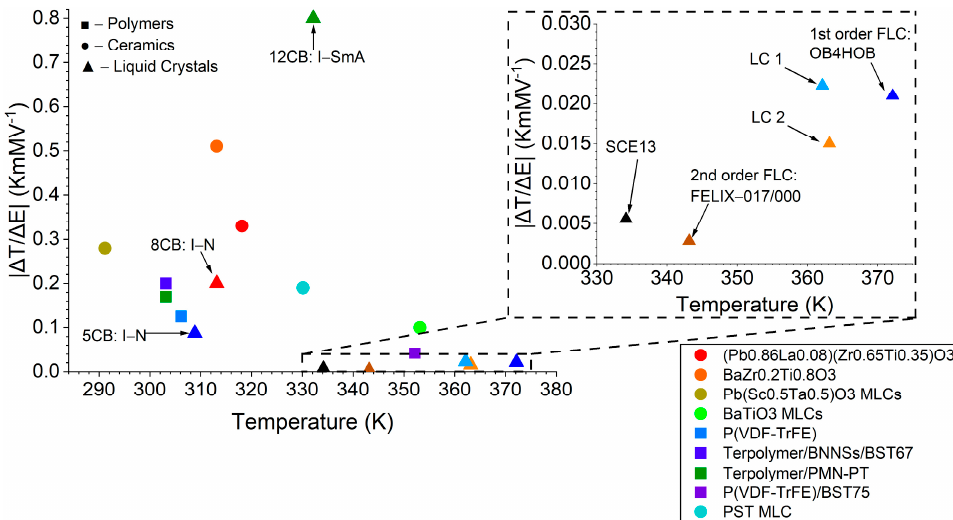
Figure 6. The EC figure of merit, ∆ T / ∆ E , plotted as a function of the temperature at which the maximum EC effect was recorded. Results for LCs (triangles and labelled) and a sample of solid EC materials, including polymers (circles) and ceramics [12,39] (squares), are shown. Data for 8CB and 12CB [25] and previously reported ferroelectric LCs [10] are also shown for comparison. The inset graph is an expansion of the dotted rectangle between 330 K and 375 K that expands the region containing ferroelectric LCs.